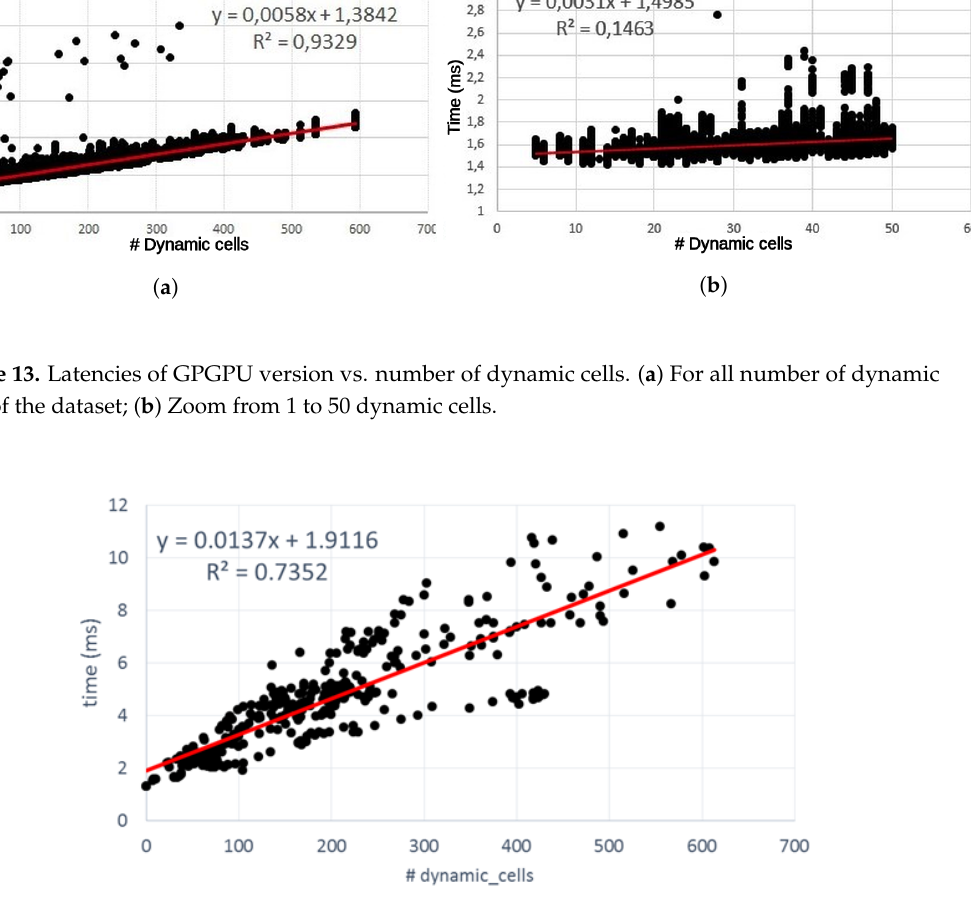
Figure 14. Latencies of FPGA version versus number of dynamic